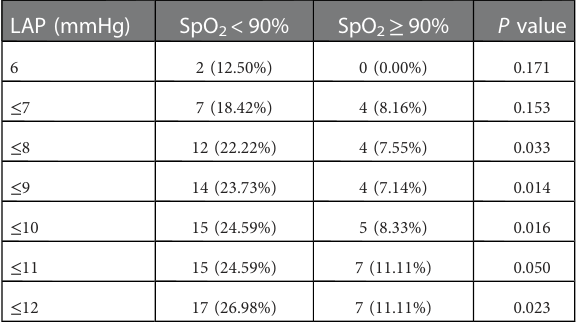
TABLE 3 Comparison of prolonged mechanical ventilation between groups based on each level of LAP within the normal